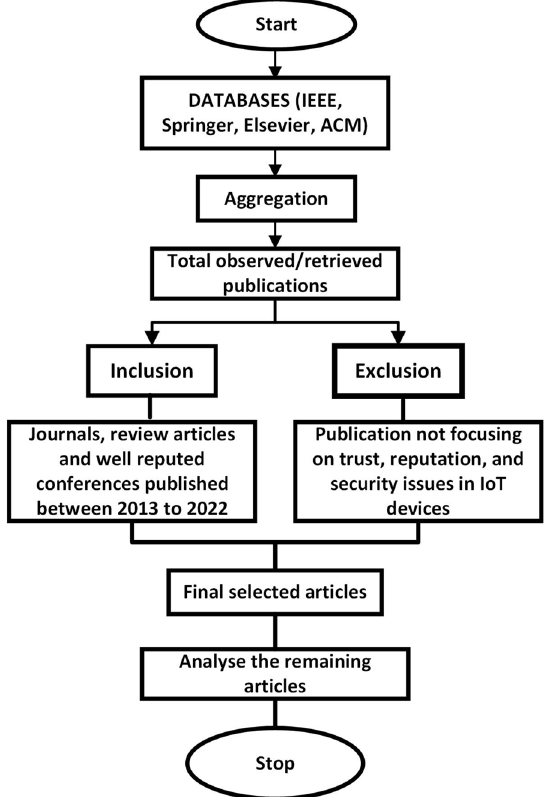
Fig. 1 Methodology for inclusion and